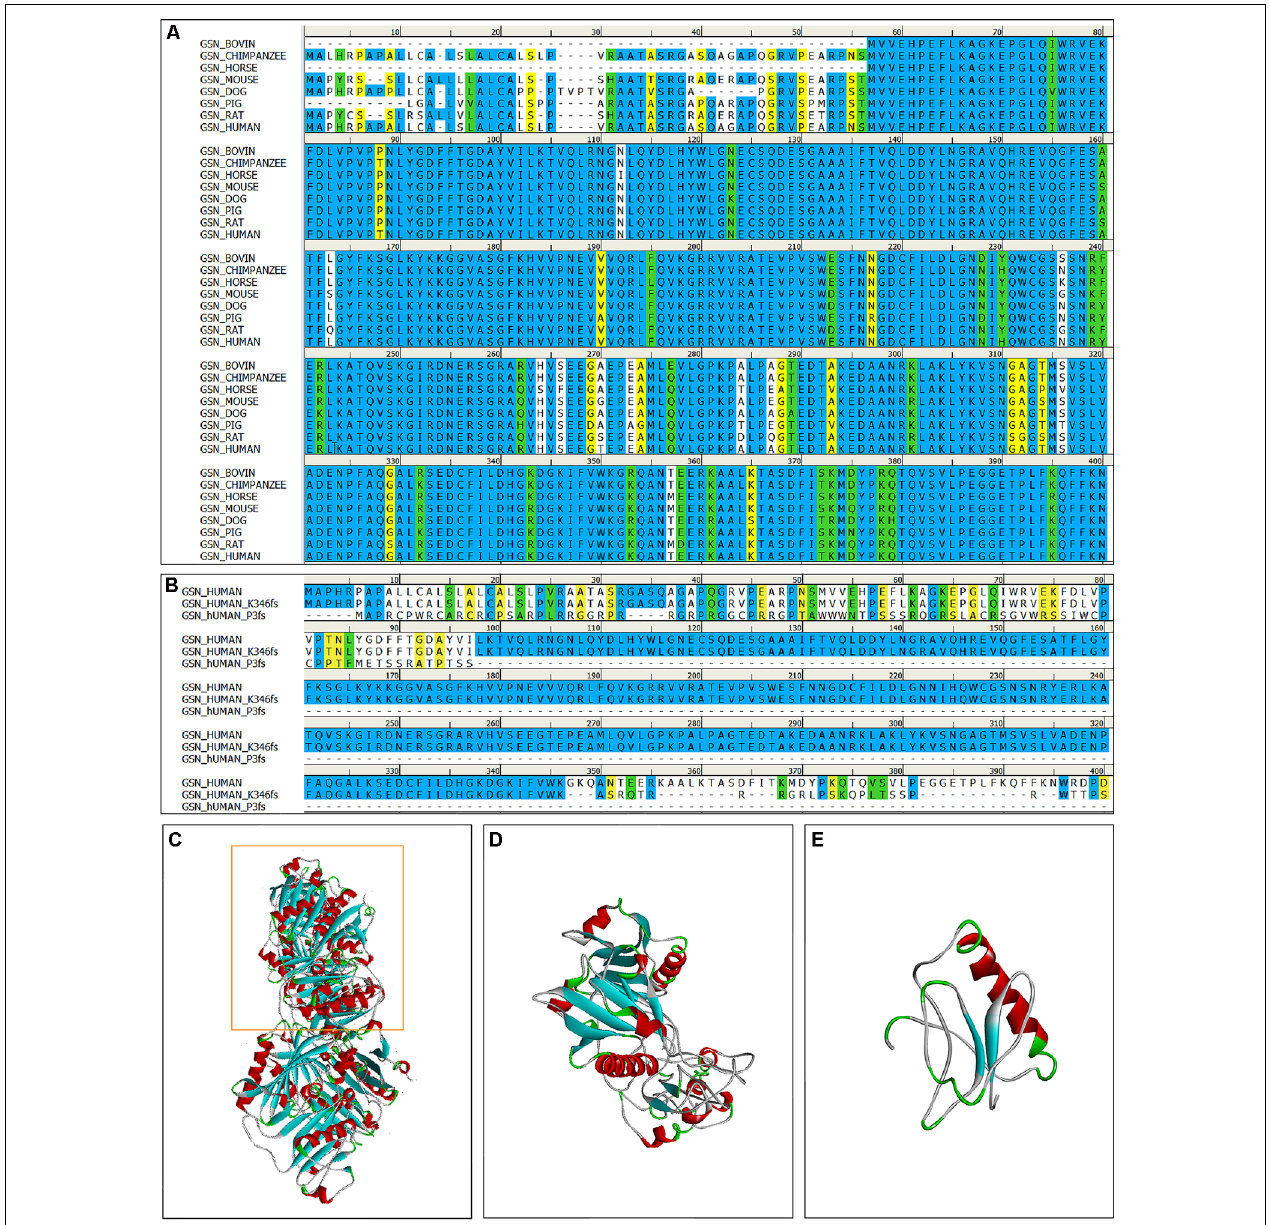
FIGURE 3 | The multiple sequence alignment and 3D models of the mutant protein structures. (A) The multiple sequence alignment of the gelsolin protein among vertebrates (amino acid residues 1–400); The degree of conservation between sequences was showed in different colors (identical: bule, strong: green, weak: yellow, non-matching: white). (B) The multiple sequence alignment of the gelsolin protein, K346fs and P3fs mutant gelsolin protein (amino acid residues 1–400). (C) 3D model of the wild-type gelsolin. (D) 3D model of the mutant protein with K346fs mutation, which is similar to part of the wild-type gelsolin (yellow box in C ). (E) 3D model of the mutant protein with P3fs